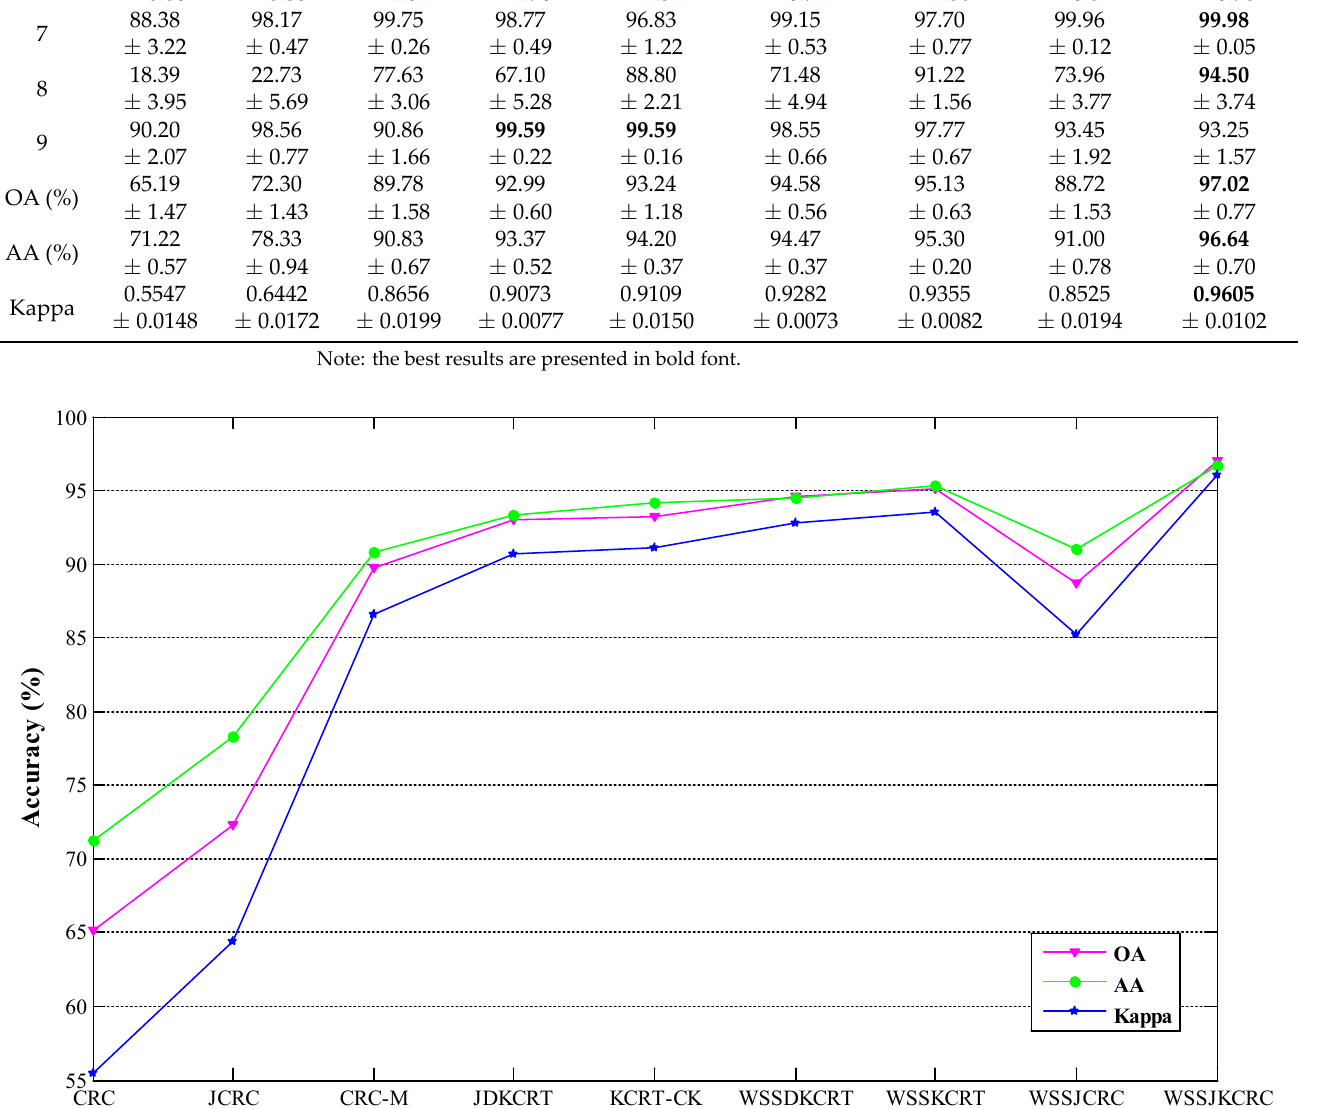
Figure 13. Land cover classification maps generated by different methods on the Pavia University scene: ( a ) ground truth, ( b ) CRC, ( c ) JCRC, ( d ) CRC-M, ( e ) JDKCRT, ( f ) KCRT-CK, ( g ) WSSDKCRT, ( h ) WSSKCRT, ( i ) WSSJCRC, and ( j ) WSSJKCRC. The CRC-M, JDKCRT, and KCRT-CK method perform spatial smoothing filtering on all pixels of HSI by directly averaging the spatial neighboring pixels, which reduces the noise in the original spectral curves of ground objects to a certain extent. Therefore, the classification performance of these three methods on the three hyperspectral scenes is sig- nificantly better than that of CRC, as shown in Table 4 and Figure 10, Table 5 and Figure 12, and Table 6 and Figure 14. However, these three methods do not consider the spectral